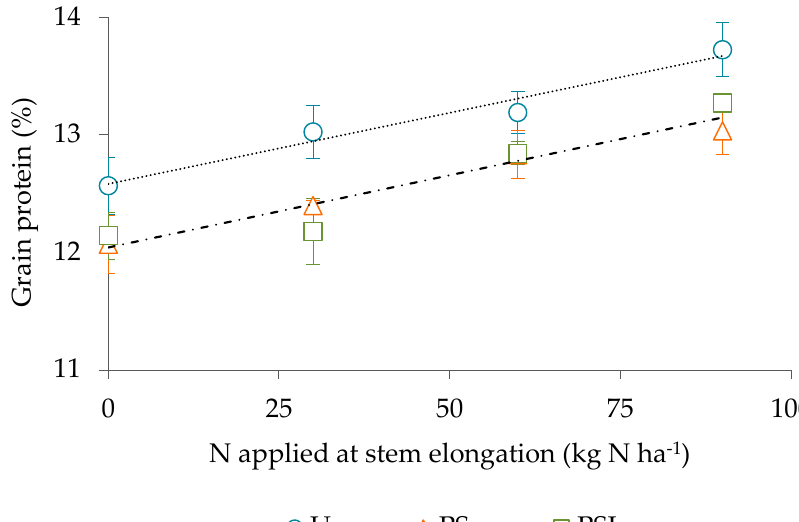
Figure 2. Relationship between the 3-year average grain protein (%) and the rate of synthetic-N applied at stem elongation (kg N ha − 1 ) for the different fertilizer strategies (U, PS, or PSI). Vertical bars indicate the standard error ( n = 4).